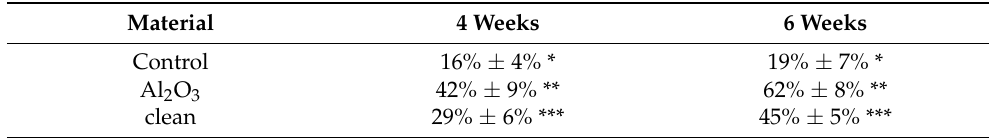
Table 6. Total bone area (BAT) for different types of Ti dental implant surfaces and after 4 and 6 weeks of implantation. Statistical differences for each column are indicated by single asterisk and double or triple asterisk symbols ( p < 0.05).